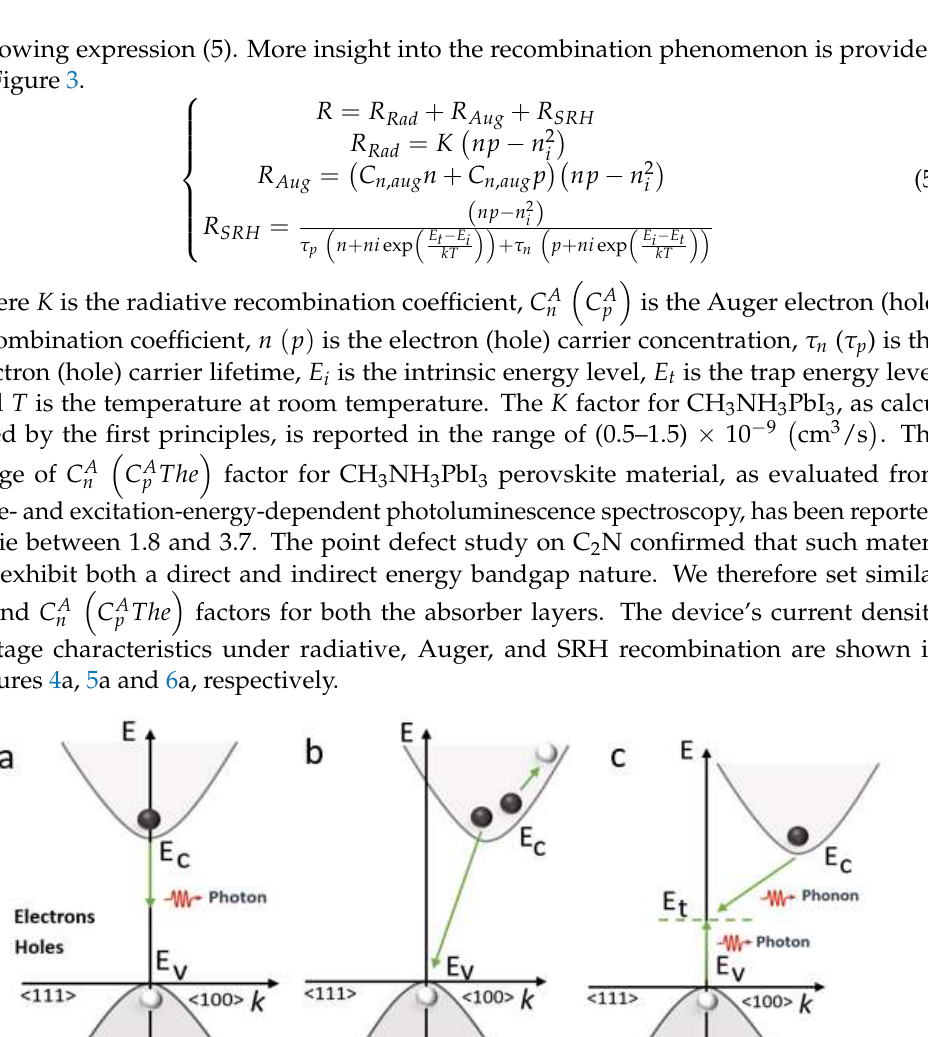
Figure 5. ( a ) Current density–voltage characteristics of a solar cell under auger recombination; ( b ) influence of Auger recombination coefficient on the open circuit voltage, short circuit current den- sity, fill factor, and efficiency of the solar cell.